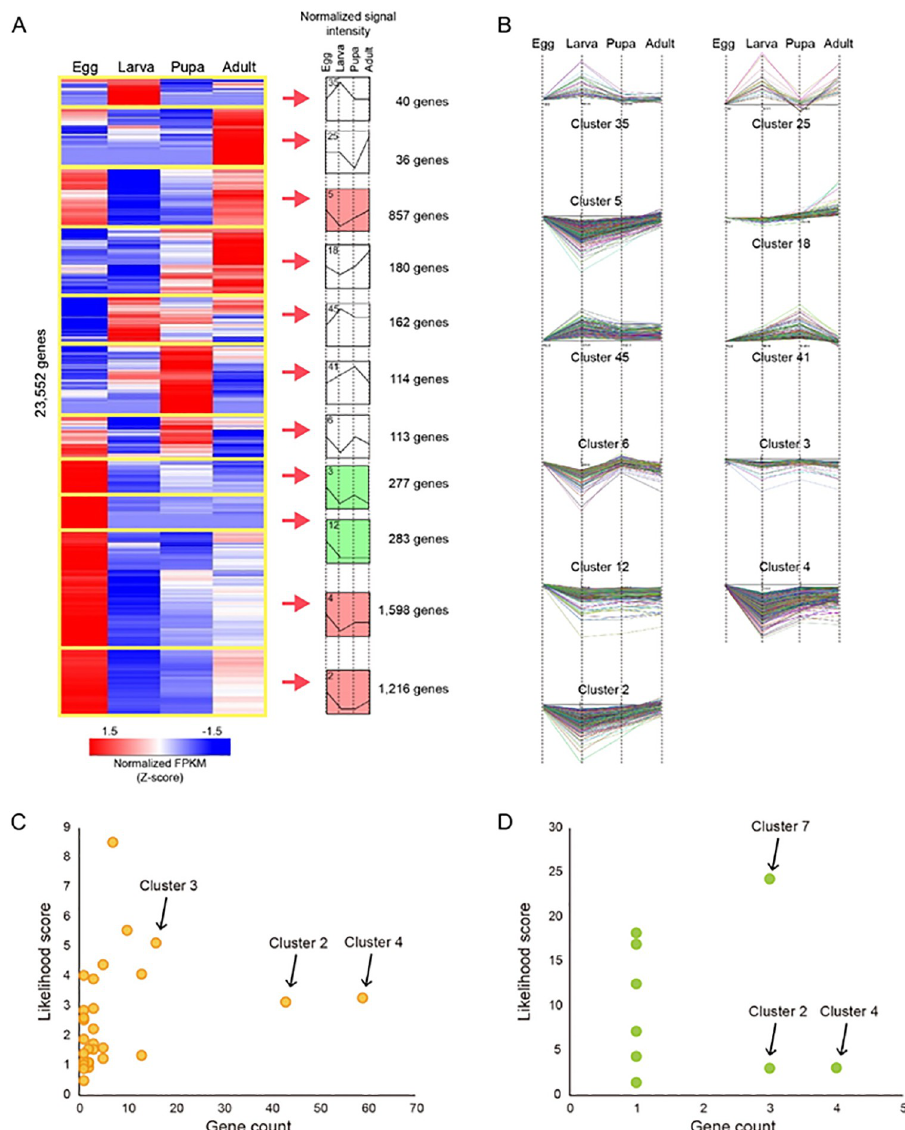
Fig 2. Trend analysis based on gene expression abundance. ( a ) Heatmap shows 23,552 transcripts. The gene counts were normalized into Fragments Per Kilobase of transcript per Million mapped reads (FPKM), then averaged by life stage. The FPKM values for each gene were transformed and then hierarchically clustered using Pearson correlation. Clustering was performed based on similarities between gene expression profiles throughout the developmental stages. The mean expression values for each gene at each of the four developmental stages were normalized to the mean expression values in the former developmental stages to represent expression levels. Groups were chosen based on similar expression patterns over 0.7 of the Pearson correlation coefficient. After clustering the expression profiles, the number in the top left-hand corner of a profile box is the profile ID number. We assigned the number of genes on the right side of each cluster. Nonwhite profiles of the same color represent profiles grouped into a single cluster. White profiles represent the statically non-significant profiles of gene expression. ( b ) Detailed expression profiles of the genes in each cluster. Selected profiles were statically significant. ( c ) Likelihood score and gene count analysis of each cluster’s wing development-related genes. The likelihood score is calculated based on the observation values divided by the expectation values. ( d ) Likelihood score and gene count analysis of the metamorphosis-related genes in each cluster.